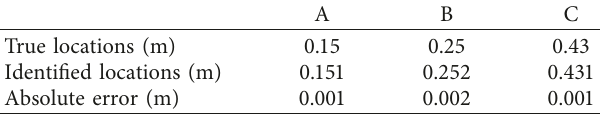
Table 4: Identified locations of the experiment.